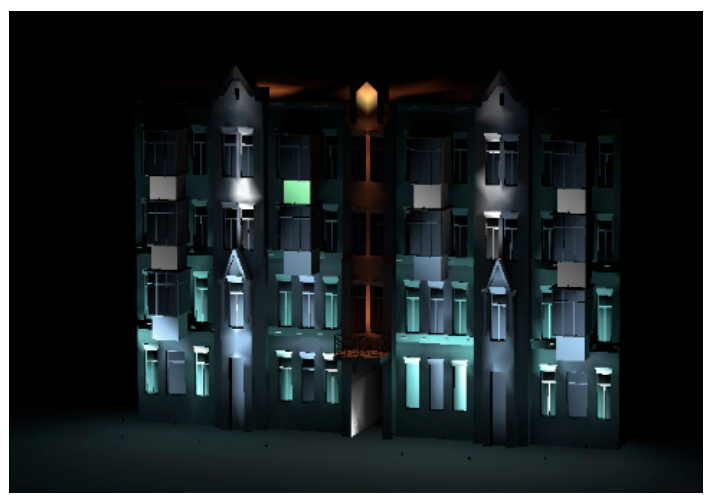
Figure 31. Fast communication of impressionism based on Monet’s painting “Impression”—Scene 6.